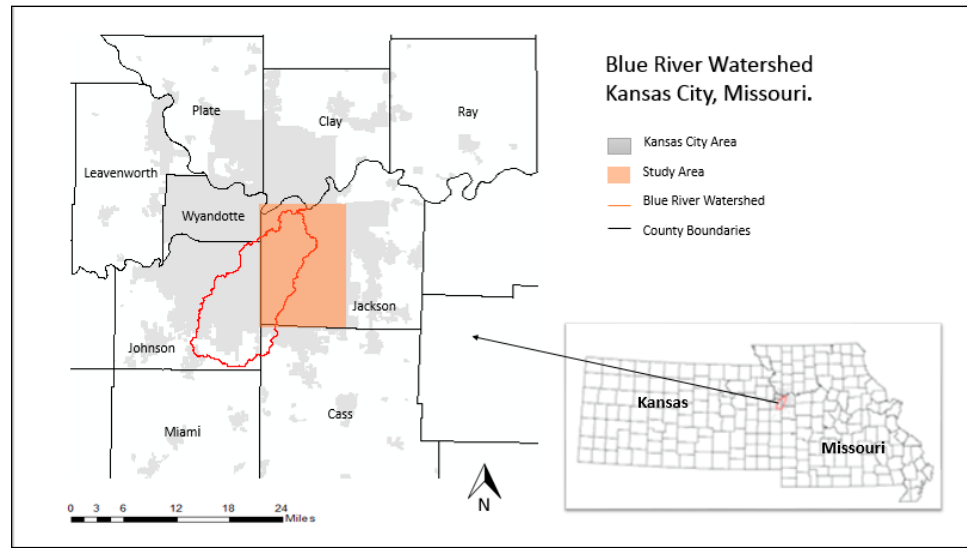
Figure 2. Blue River Watershed in Kansas City, Missouri, USA.